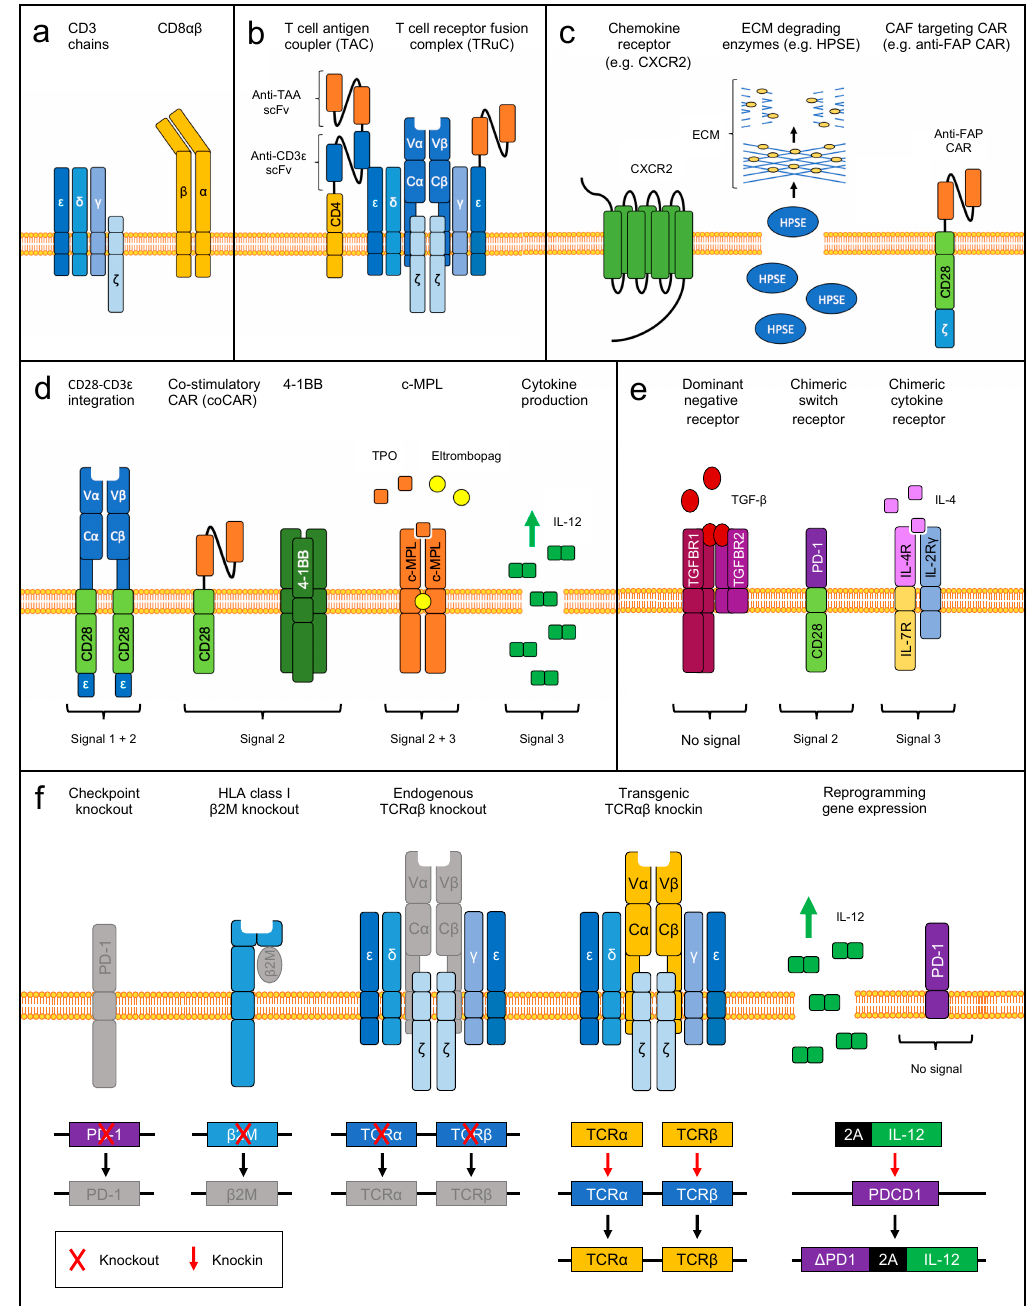
Figure 3. Engineering strategies to enhance function of TCR transgenic T cells: ( a ) Co-expression of TCR signaling components (CD3 and CD8 αβ ). ( b ) Engineering MHC-independent antigen specificity with signaling through the TCR. ( c ) Engineering improved T cell homing and infiltration into the tumor. ( d ) Engineering the delivery of co-stimulatory and cytokine signals in the TME. ( e ) Engineering the reversion of immune inhibitory signals in the TME ( f ) Genome editing strategies to improve T cell function.